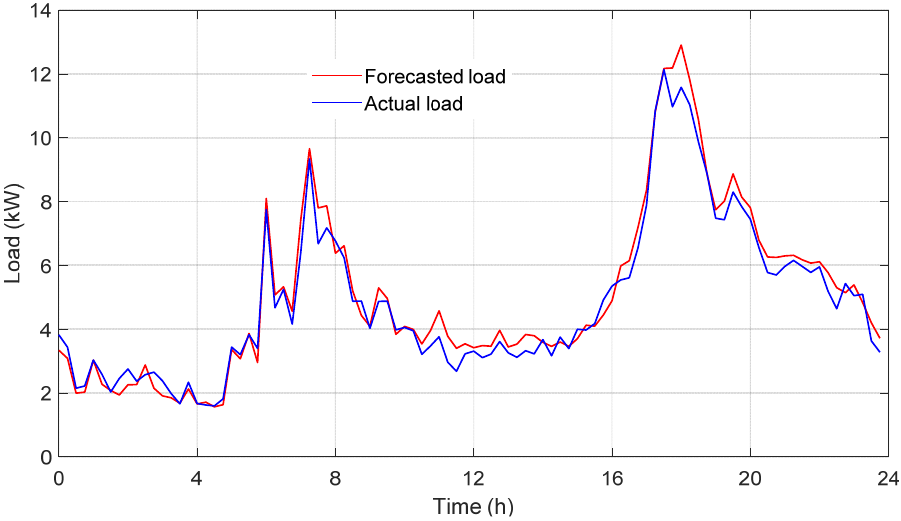
Figure 5. Forecasted and the actual load demand for a day ahead using a sample time of 15 min.